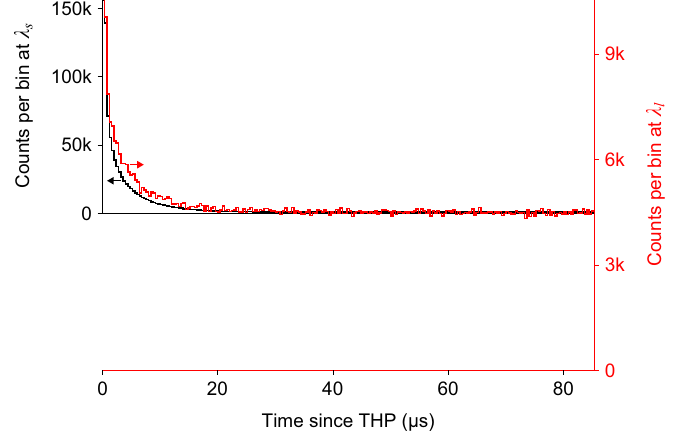
Figure 3. Afterpulse profiles at λ s = 1536 nm and λ l = 1924 nm. Note that the histograms are rescaled such that their peak counts and dark count rates match in the plot, making visual comparison of decay curves easy. The decay curves are similar but not identical. A total of 10 6 counts were histogrammed at each wavelength. The originally collected histogram data exhibited a saturation effect, in which count rate in later bins was slightly suppressed (by 6.4% for λ s , 1.0% for λ l ) because of significant click probability in early bins. This has been corrected in the plotted histograms, increasing their total count number above 10 6 .